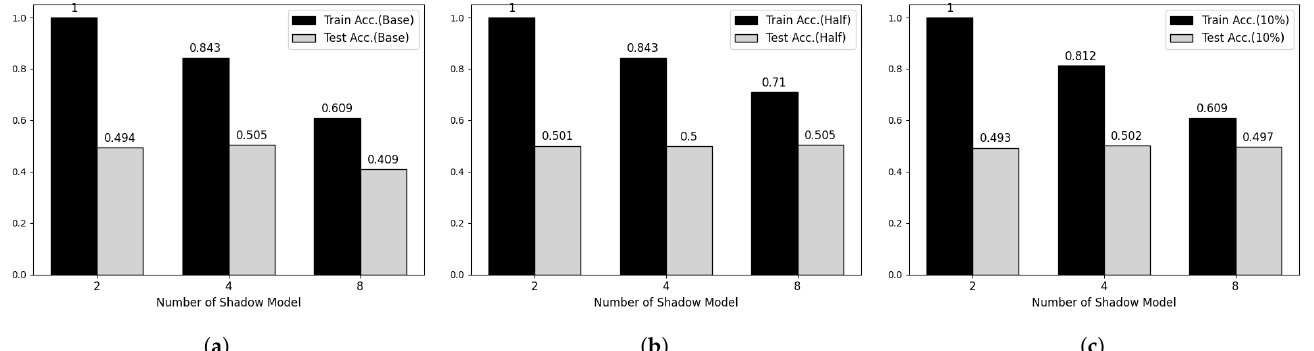
Figure 5. Membership inference attack results on MNIST datasets. ( a ) Base Model. ( b ) Half-data trained Model. ( c ) 10%-data trained Model.